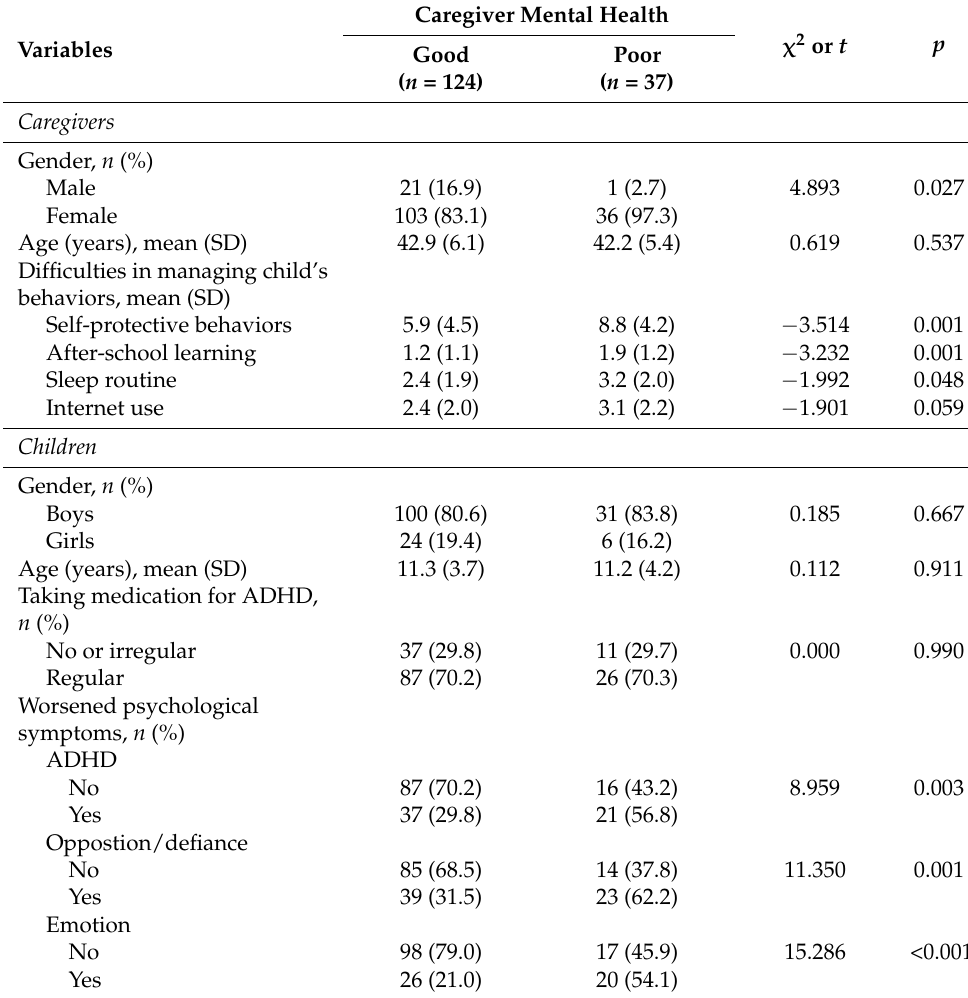
Table 3. Comparisons of Caregivers’ Demographics and Difficulties in Managing Child’s Behav- iors and Children’s Demographics, Treatment, and Worsened Psychological Symptoms Between Caregivers with Good and Poor Mental